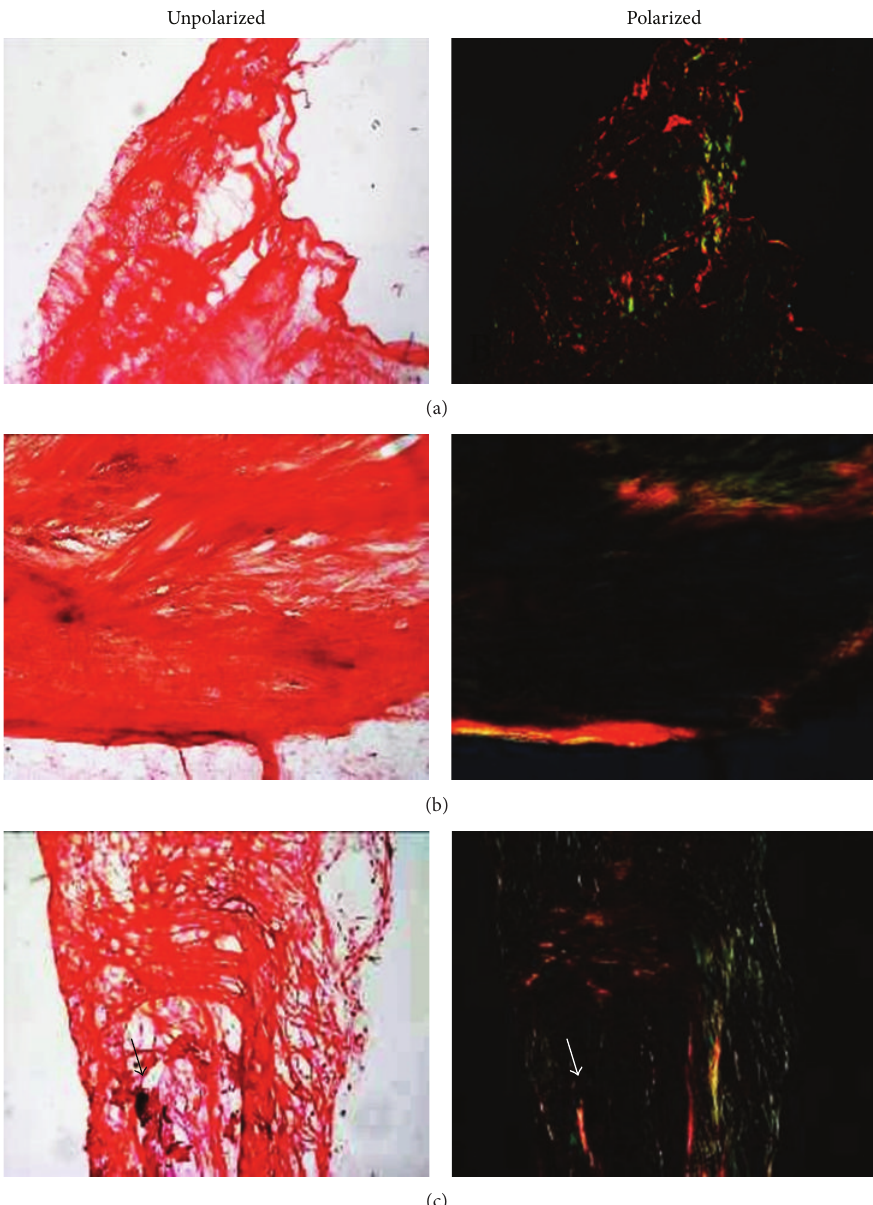
Figure 5: Congo Red staining of AKU aortic valve amyloid deposits. Different sections of the valve are shown. Desquamation of endothelial coverage and tissue destruction were evident. Valve tissue was ever stained red (“congophilic”). The pigmented areas (arrows) were also birefringent, indicating overlapping of ochronosis and amyloid. Magnification